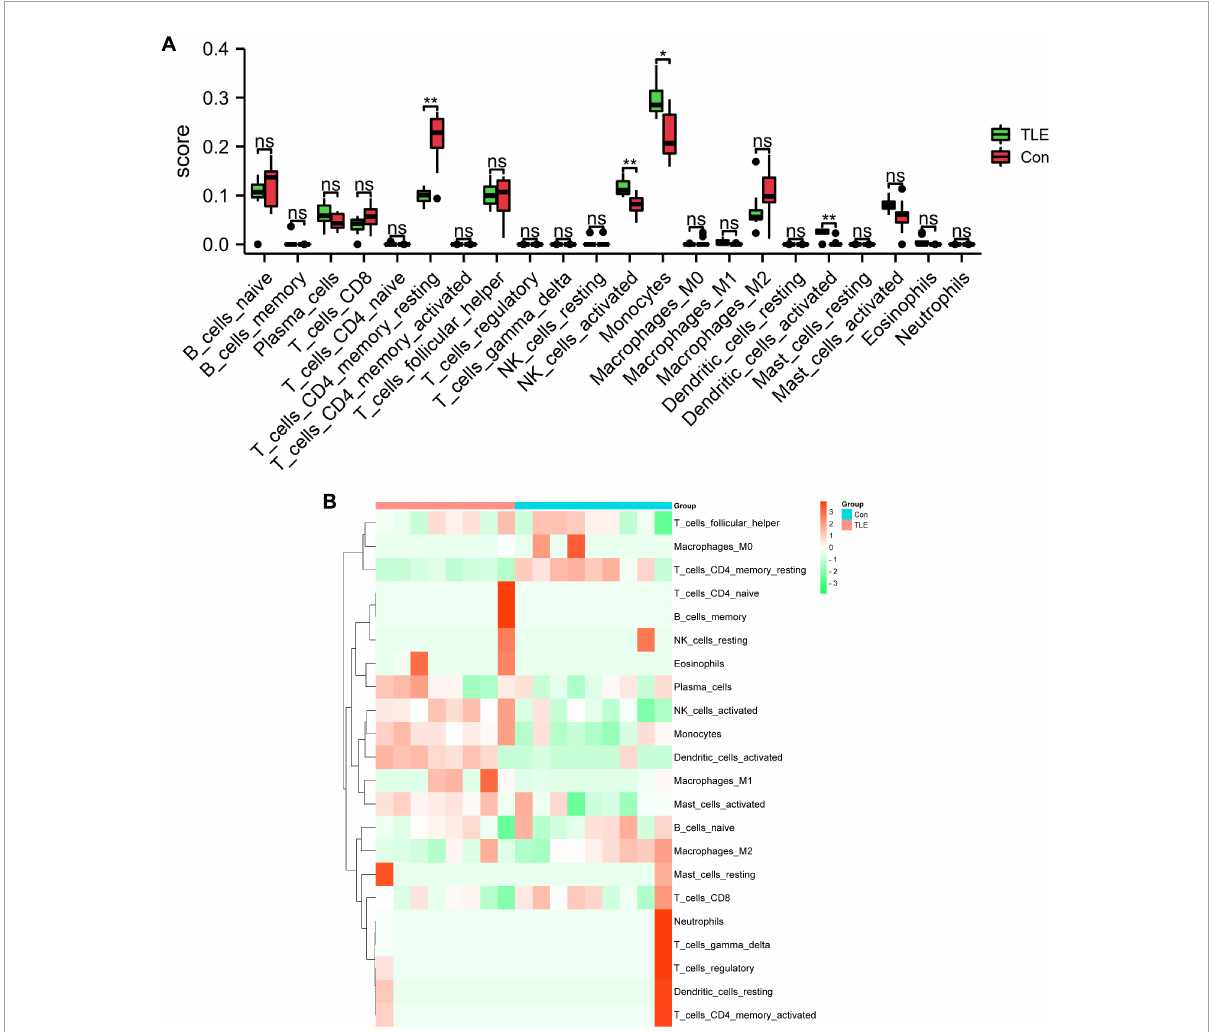
FIGURE6 Analysis of immune cell infiltration landscape in TLE. (A) The histogram exhibits the differences in the score of the 22 types of immune cells between the control and TLE group in GSE88992 dataset. (B) Heatmap exhibited distribution of 22 types of immune cells between the control and TLE group in GSE88992 dataset. * P < 0.05, ** P <